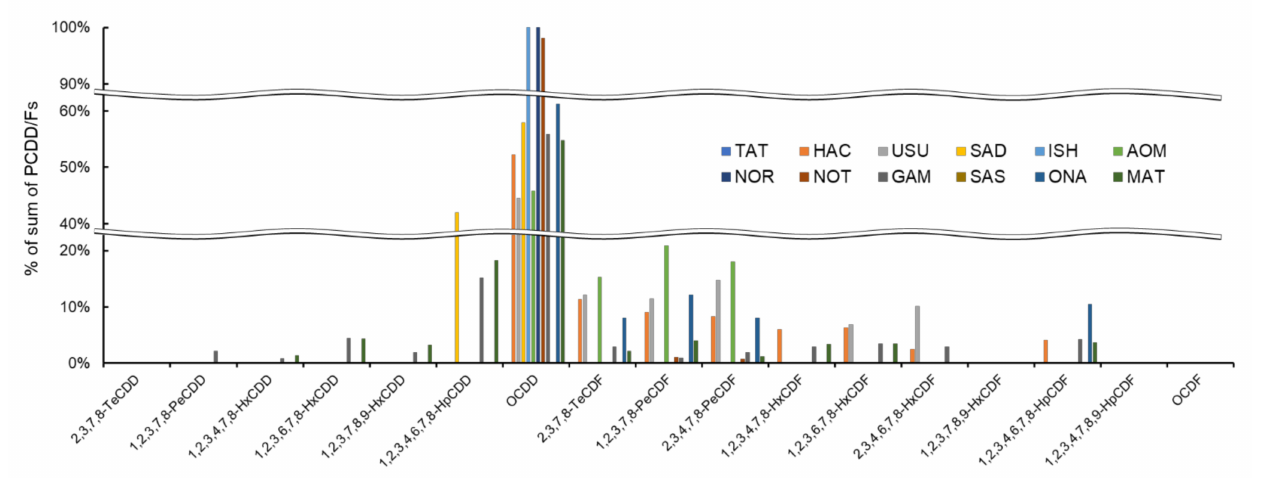
Figure 3. Percentage of individual PCDD/Fs for sum of PCDD/Fs at 11 sampling sites.